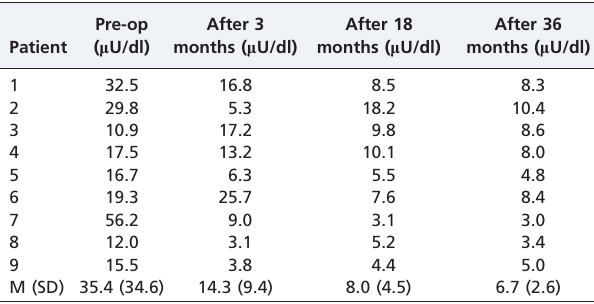
Table 5 - Fasting insulin levels: Comparison between preoperative values and values at 3, 18, and 36 months after surgery. All postoperative values were significantly lower ( p , 0.05). M= mean; (SD)= standard deviation.